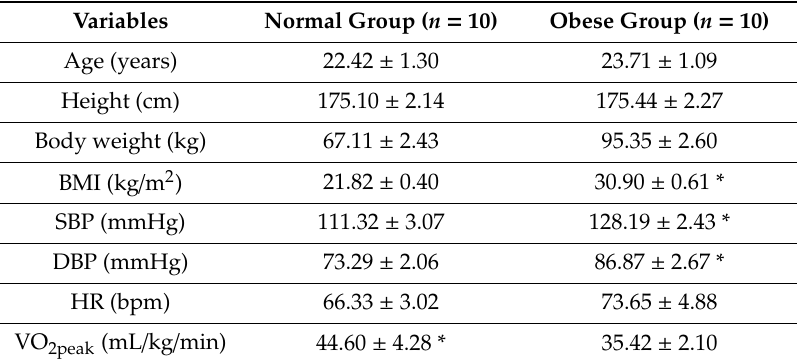
Table 1. Physical characteristics of subjects.